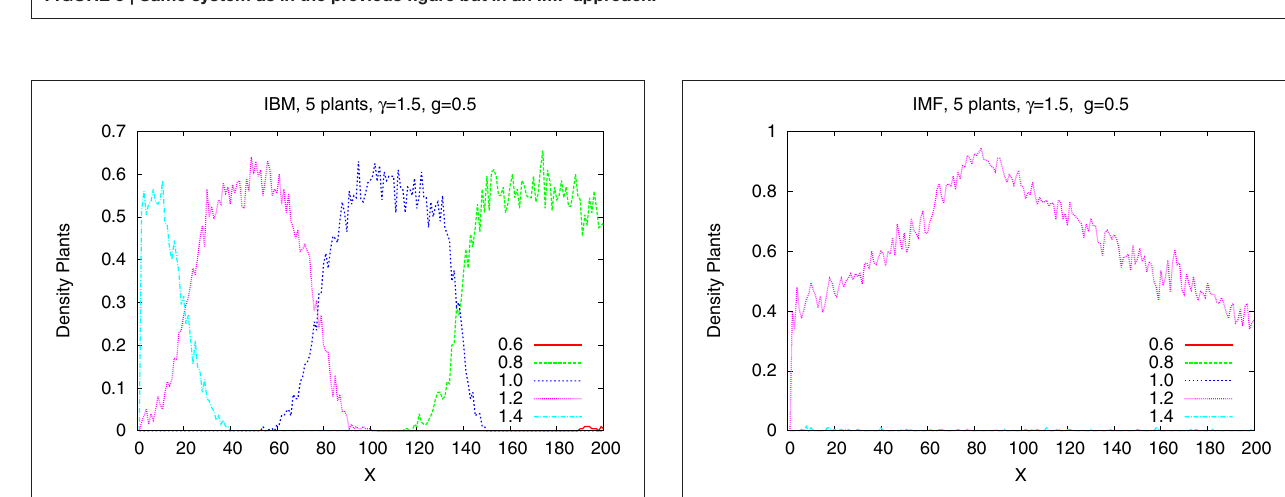
FIGURE 5 | Same system as in the previous figure but in an IMF approach.